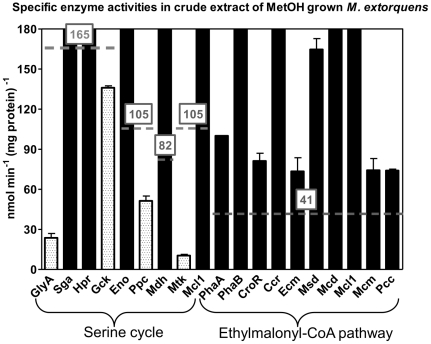
Postulated limiting steps in methanol assimilation in M. extorquens AM1.The grey dashed lines indicate the calculated minimal value for the specific activity of enzymes, which is required to account for the observed generation time of 3 hours on methanol.